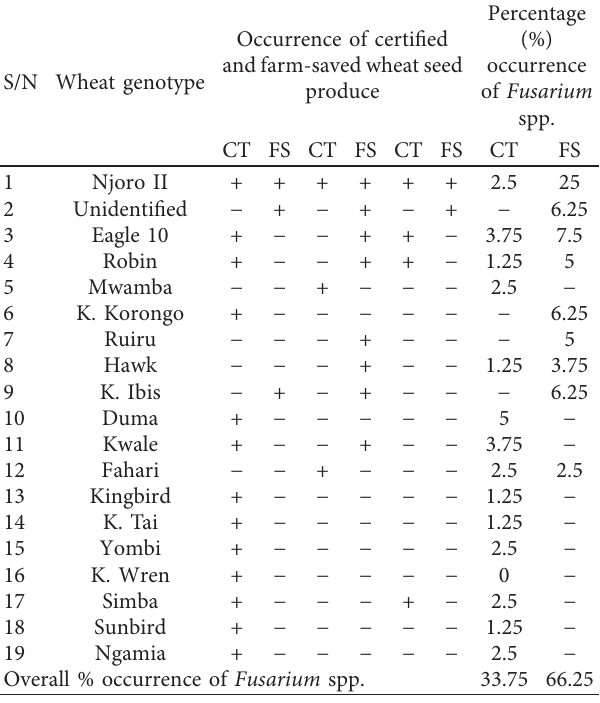
Table 2: Produce of certified and farm-saved genotypes of wheat seeds and overall occurrence of Fusarium spp.